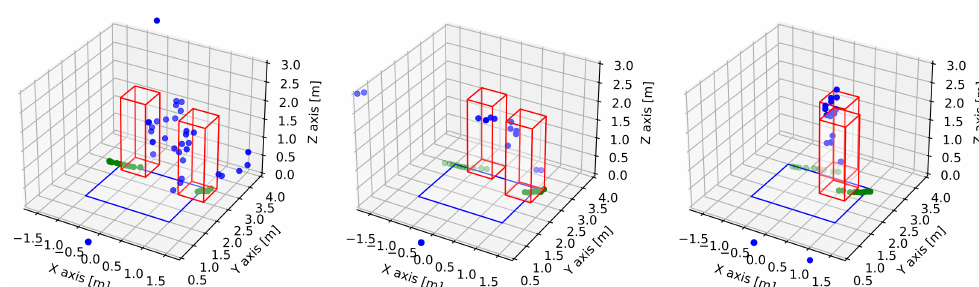
Figure 14. Two pedestrians in scenario four are being tracked by the GTRACK algorithm. Both pedestrians are entering the observation zone in opposite directions and are moving with higher tangential velocities than their radial velocities v t > v r .